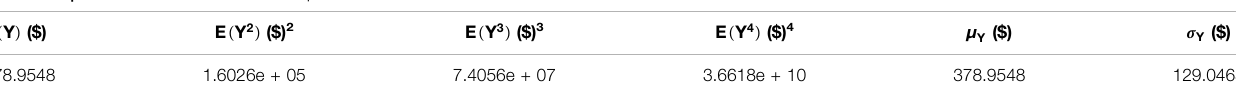
TABLE 13 | Statistical moments of total expected cost for Case 1.